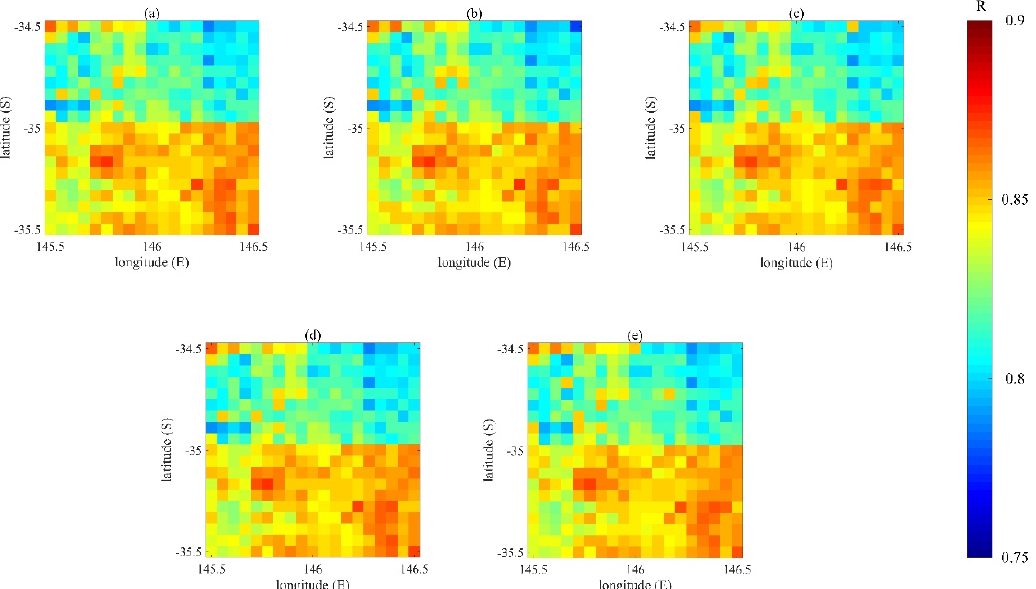
Figure 7. The R values between the CCI data and the assimilated data with ensemble sizes of: ( a ) 20; ( b ) 50; ( c ) 100; ( d ) 200; and ( e ) 500. Table 4. The mean and variance of the RMSE and R between the CCI data and the data assimilation experiments with different ensemble sizes.